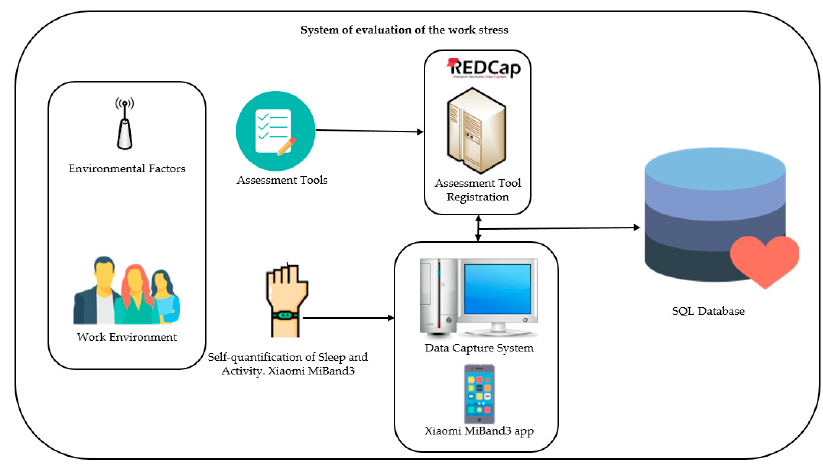
Figure 1. Registration and capture of biometric data and the assessment process.